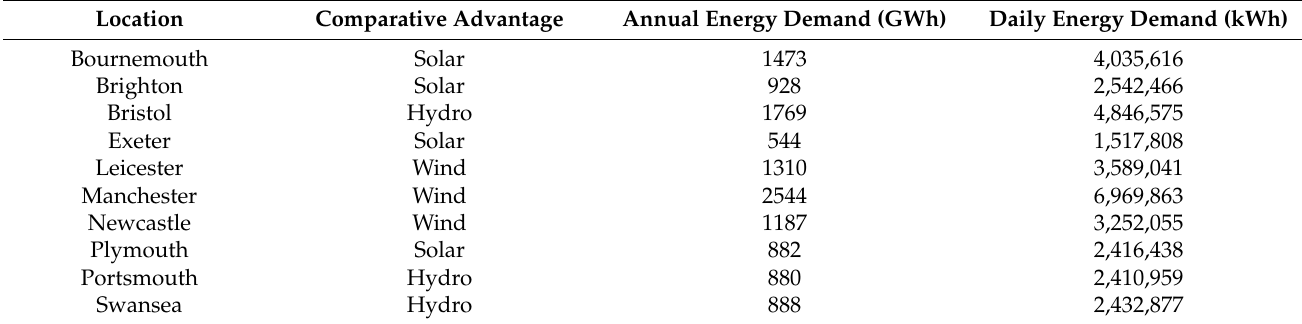
Table 1. Modelling locations